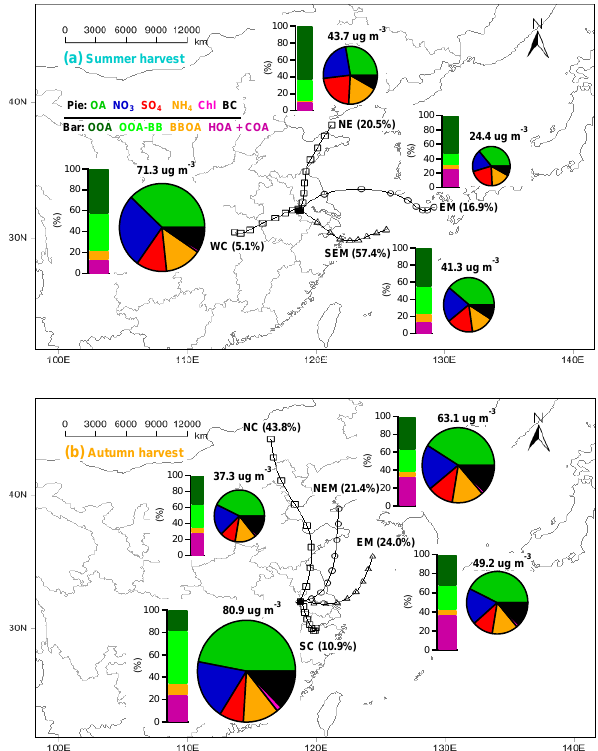
Figure 12. Average composition of PM 1 (pie charts) and OA factors (bar charts) for each cluster. The four clusters are (a) northeasterly (NE) back trajectories (BTs), easterly marine (EM) BTs, southeast- erly marine (SEM) BTs, and westerly continental (WC) during the summer harvest; and (b) northerly continental (NC) BTs, northeast- erly marine (NEM) BTs, easterly marine (EM) BTs, and southerly continental (SC) during the autumn harvest. The markers on the tra- jectories indicate 6h